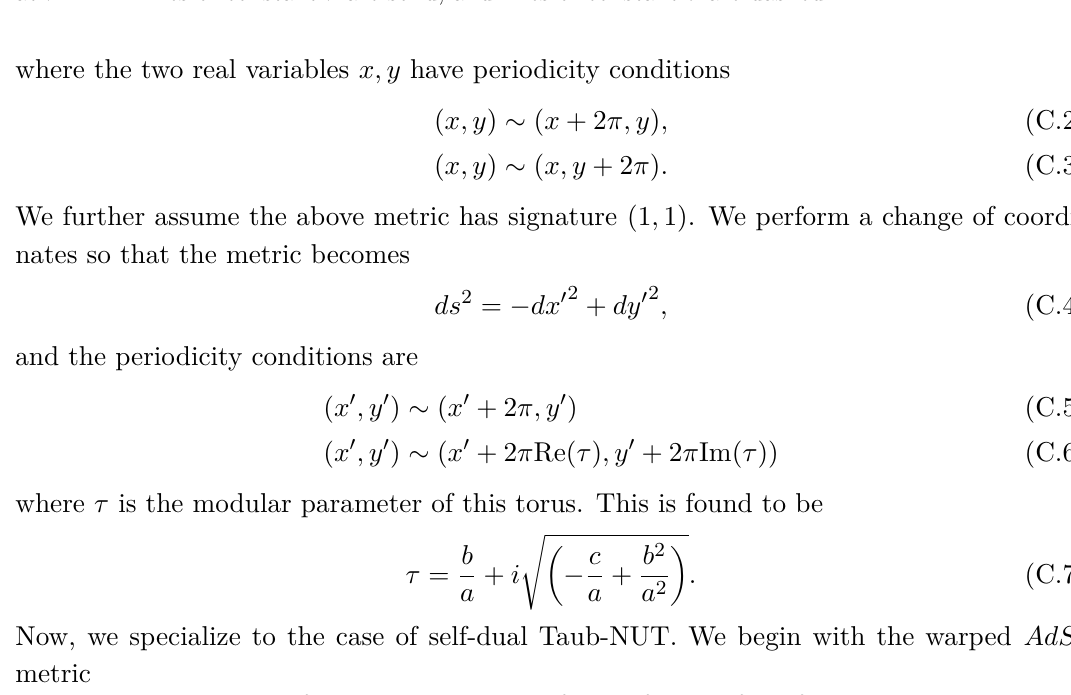
Figure 5. The toric Penrose diagram for (2 , 2) Taub-NUT with M = 0 . There is a naked singularity at r = N . Lines of constant r are solid, and lines of constant θ are